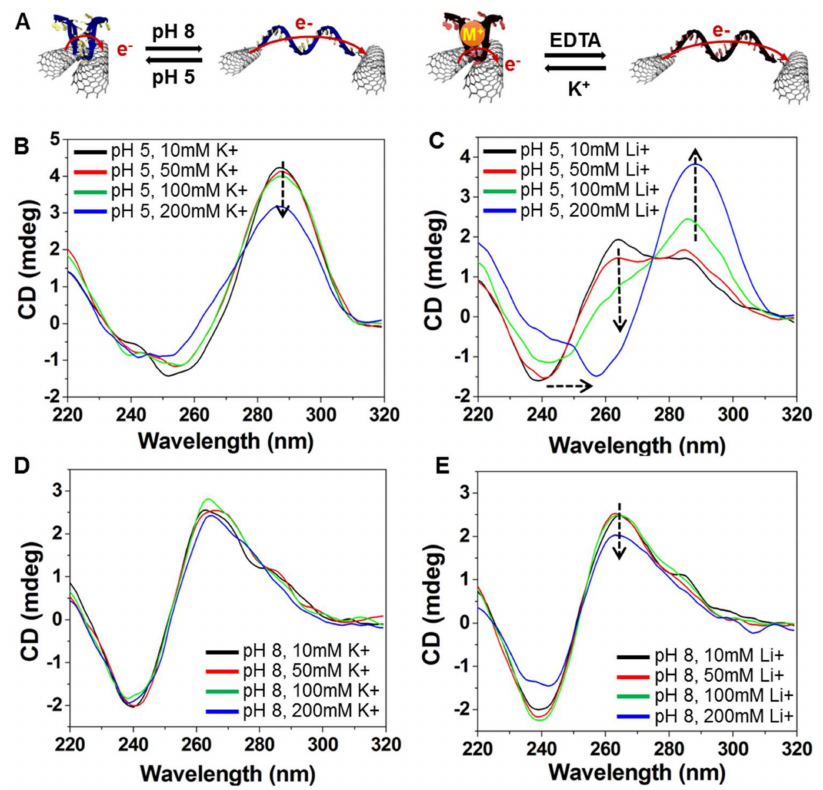
Figure 3. ( A ) Schematic representation of conformational change in response to pH and ion (M + ) stimuli on i-DNA/f-SWNT (left side) and G-quadruplex/f-SWNT (right side); ( B – E ) Circular Dichroism (CD) spectra of a mixture of i-DNA/f-SWNT and G-quadruplex/f-SWNT at various concentrations (10, 50, 100, and 200 mM) of K + and Li + ions in pH 5 ( B , C ) and pH 8 ( D , E